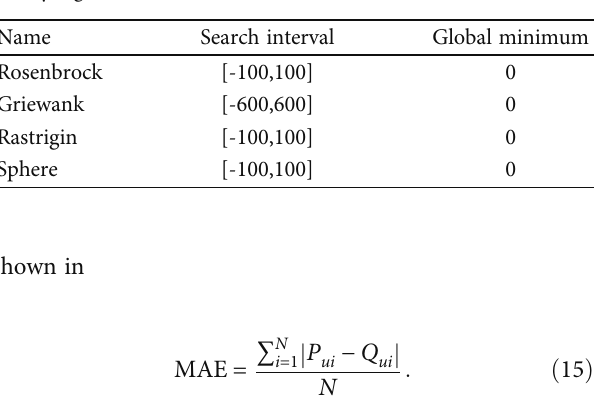
Table 4: Characteristics of four test functions of improved bee colony